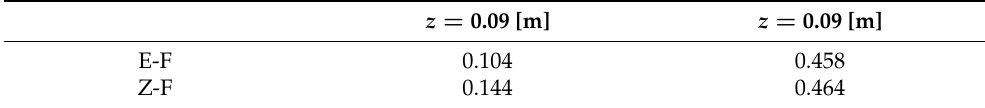
Figure 8. Comparison between measurements and models at the wing unit location ( x = 23m) showing surface elevation ( a ) and sediment concentrations at 9 cm ( b ) and 19 cm ( c ) above the initial bed respectively. The sediment concentrations are modelled using the Engelund and Fredsoe [37] and Zyserman and Fredsøe [39] models, respectively. Both models use the MULES VoF approach. The last 25 s are shown with a grey background. Table 2. nRMSE figures for modelled sediment concentrations for two OBS probes. The values correspond to the full 50 s time